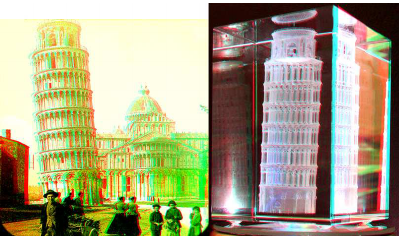
Figure 11. Historic Photographic Keystone masterpiece in 3D of the Leaning Tower of Pisa (Italy) in comparison with color anaglyphs presentation of an “early bird” lasered crystal (anaglyphs by W. Schuhr; lasered crystal: courtesy R.Titze of LOOXIS, Hannover)